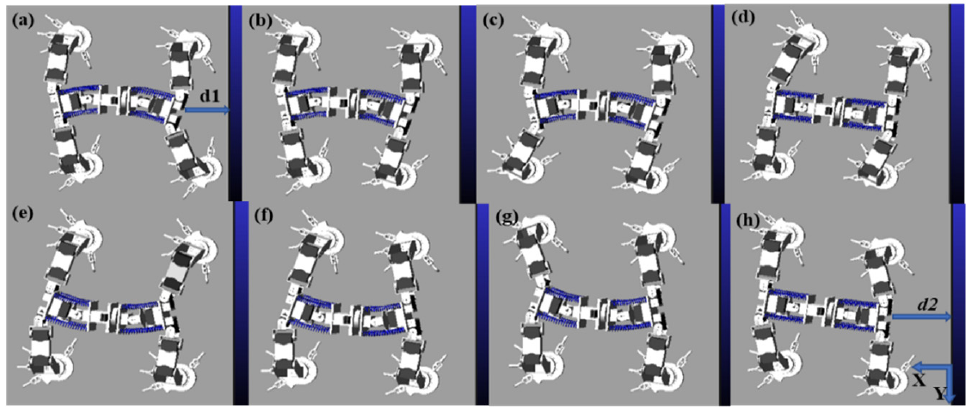
Figure 12. Tripod gait; ( a – h ) eight movements in one locomotion cycle. To observe the walking characteristics for a long period, Figure 13 plots the variations of the center of the robot mass in the X, Y, and Z (vertical direction) directions over four cycles. The value for X has increased by 430 mm, as expected. For the horizontal line in each cycle, it means that the spine is static (the center of mass is unchanged) whilst the legs are moving. The fluctuating feature means that robot moves forward with spine swinging. The fluctuations of Y displacements represent the swing amplitudes of the spine. The deviation of the center of mass in the Z-axis direction is 13 mm, which is induced by the motion variations of the legs. Nonetheless, such deviations are considered small and would not affect the motion stability